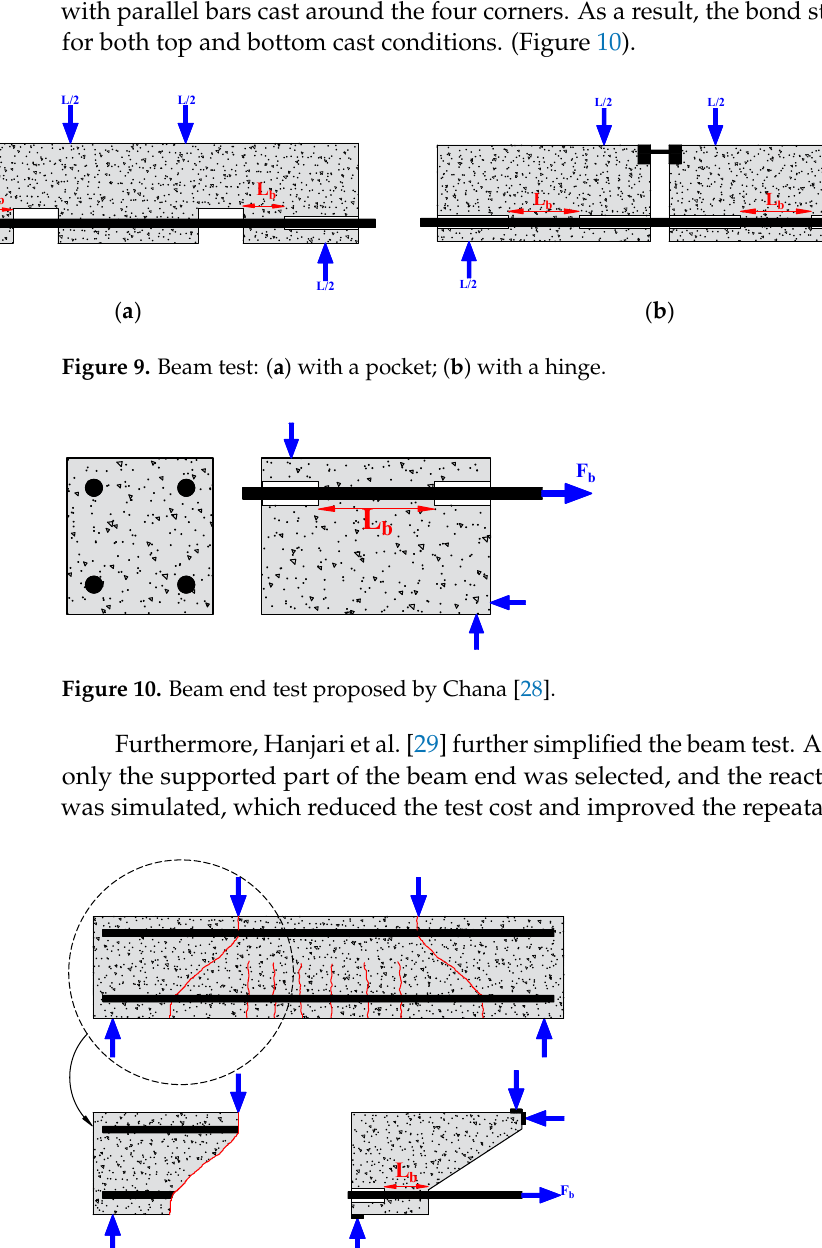
Figure 11. Modified Beam test by Hanjari et al. [29].